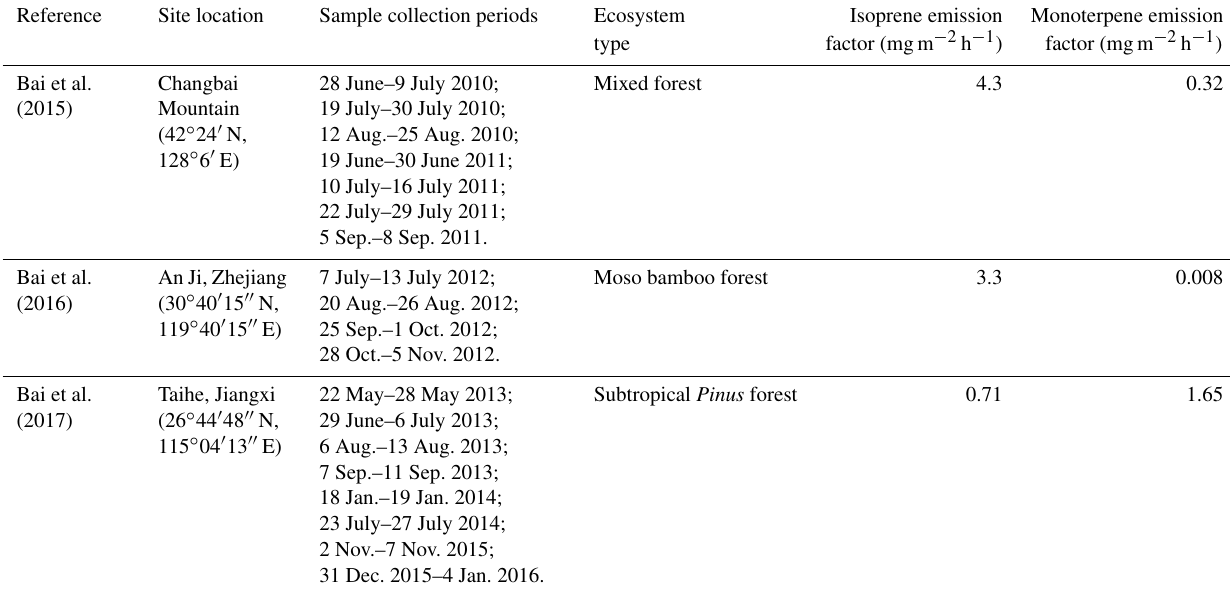
Figure 10. Comparison of the trend of isoprene emission between this study (S1) and other estimations from 2001–2016. Panels (a) and (b) are for S1 and S3, respectively, in this study, and (c) and (d) are for CAMS-GLOB-BIO v1.1 and CAM-GLOB-BIO v3.1, respectively. The Mann–Kendall test was used to mark the grids where p is smaller than 0.1. Table 7. Detailed descriptions of the flux measurements used in this study and corresponding